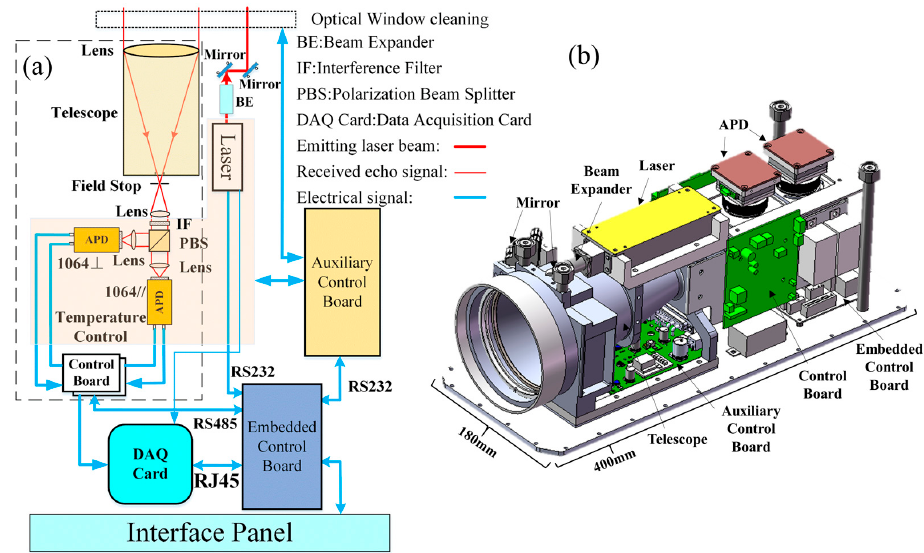
Figure 7. mIRLidar system: ( a ) schematic diagram and ( b ) internal structure diagram.